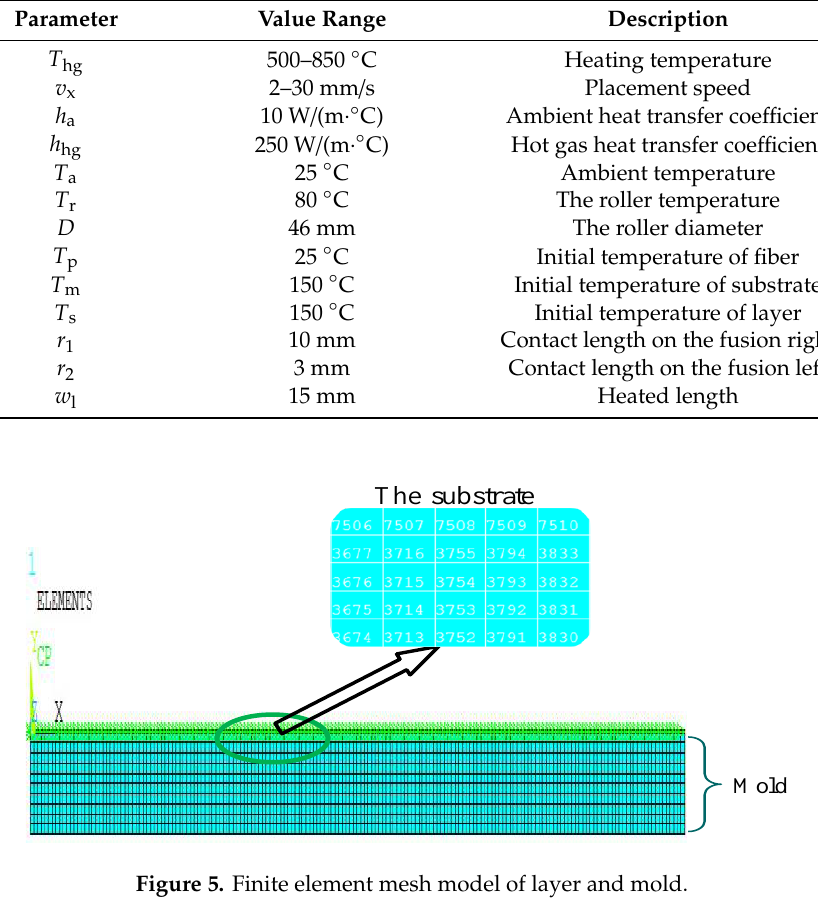
Table 3. Parameters in boundary conditions.